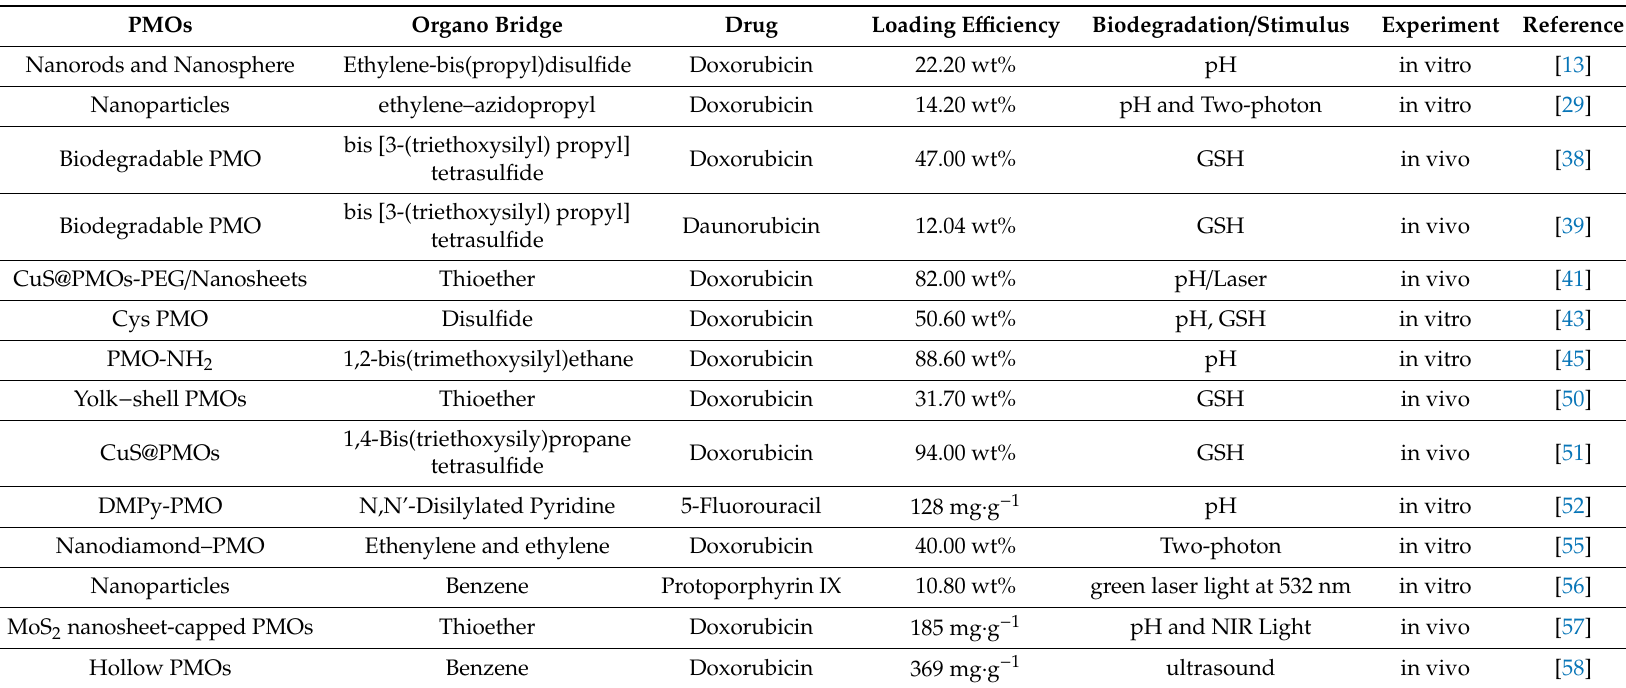
Table 1. PMOs for drug delivery with internal and external